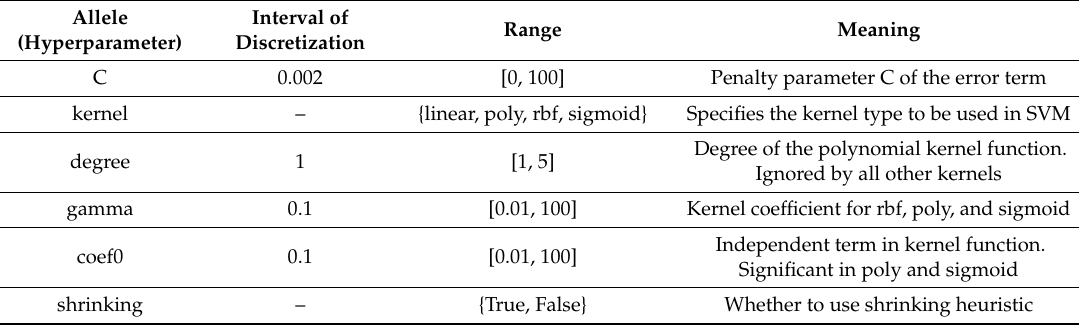
Table 4. Content of chromosome of GA applied for optimizing the values of hyperparameters of SVM. Allele